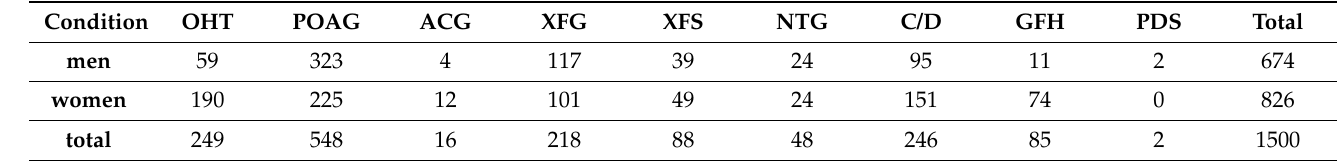
Table 1. Incidences of different reasons for conducting diurnal curve in relation to